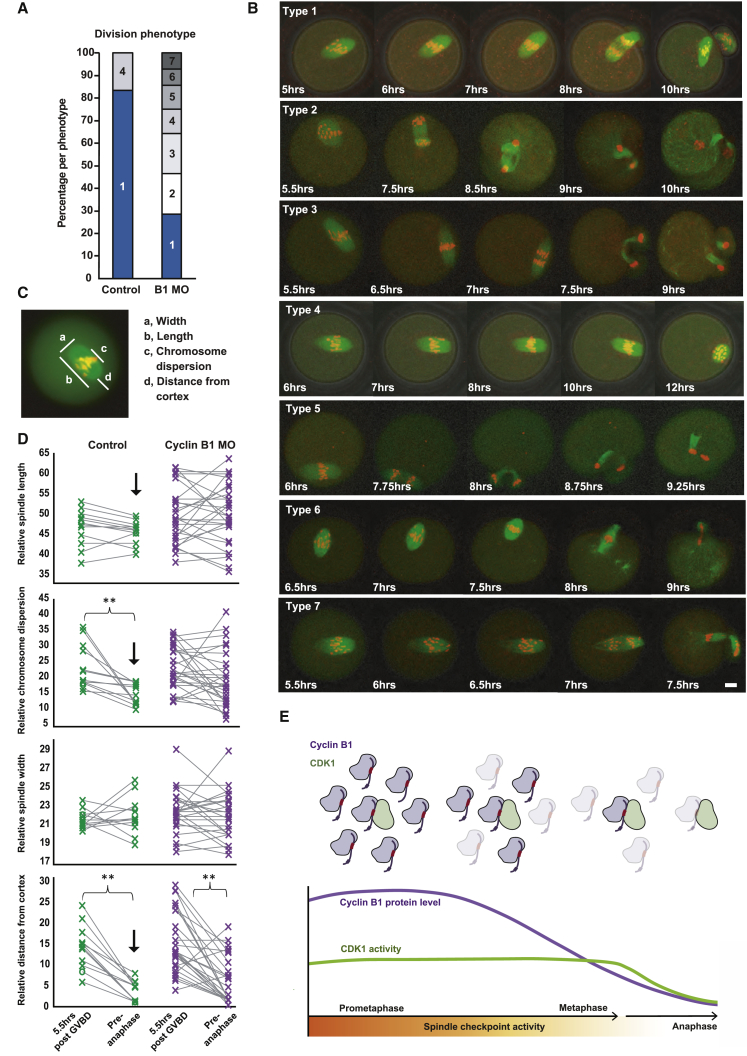
Restricting Excess Cyclin B1 Results in Division Errors in Oocytes(A) Bar chart representing the outcome of MI divisions in control and cyclin B1 MO oocytes following live confocal imaging of oocytes expressing Map7-GFP (green) and SiR DNA (red). Oocytes were imaged every 15 min from 4 to 12 h post GVBD. Phenotype 1: DNA divides between the oocyte and a PB1 with normal morphology. Phenotype 2: DNA divides between the oocyte and a PB1 that is outside of the range of PB1 sizes in control oocytes from the same oocyte pool. Phenotype 3: the oocyte undergoes anaphase and cytokinesis; however, all DNA is extruded in 1 or more polar bodies. Phenotype 4: chromosomes appear to align; however, anaphase is prevented. Phenotype 5: anaphase occurs yet cytokinesis fails, and attempted PBs are reabsorbed. Phenotype 6: “cut” phenotype; cytokinesis takes place over unseparated chromosomes. Phenotype 7: DNA divides between the oocyte and a PB1 with normal morphology, yet chromosomes do not align prior to anaphase.(B) Example images of spindle movements and division phenotypes represented in (A). Phenotypes are also available to view as movies in Video S1. Scale bar, 10 μm.(C) Image representing spindle parameter measurements in live maturing control (n = 12) and cyclin B1 MO (n = 28) oocytes. As in Figures 5B and 5C, each parameter was measured relative to oocyte size. “Chromosome dispersion” = the distance over which chromosomes are dispersed over the inter-polar axis. “Distance from the cortex” = distance from the cortex to the nearest spindle pole in the direction of spindle movement.(D) Graphs showing changes in oocyte spindle parameters (as indicated) between 5.5 h post GVBD and “pre-anaphase” (the last image collected before anaphase) in control (green, n = 12) and cyclin B1 MO oocytes (purple, n = 28). Gray lines highlight paired data measurements taken in the same oocyte. ∗∗ denotes a significant difference in means (p < 0.005). ↓ denotes a significant difference between the variance of the control dataset and the variance of the cyclin B1 MO dataset pre-anaphase. These data are also represented as boxplots in Figure S7. See Tables 1 and S1 for p values.(E) Model of free cyclin B1 destruction ahead of CDK1-bound cyclin B1 destruction in MI mouse oocytes. As spindle checkpoint activity declines in late prometaphase, an excess of free cyclin B1 is targeted for destruction via its D-box (black) and PM motif (red) in preference to CDK1-bound cyclin B1. CDK1-bound cyclin B1 is initially preserved, targeted at a later time point via its D-box only, coinciding with more complete spindle checkpoint satisfaction and the establishment of stable end-on kinetochore attachments.